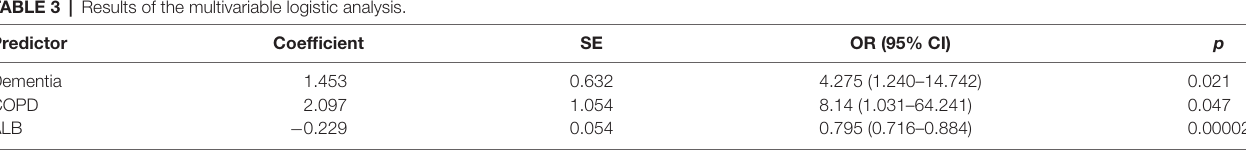
COPD, chronic obstructive pulmonary disease; ALB,